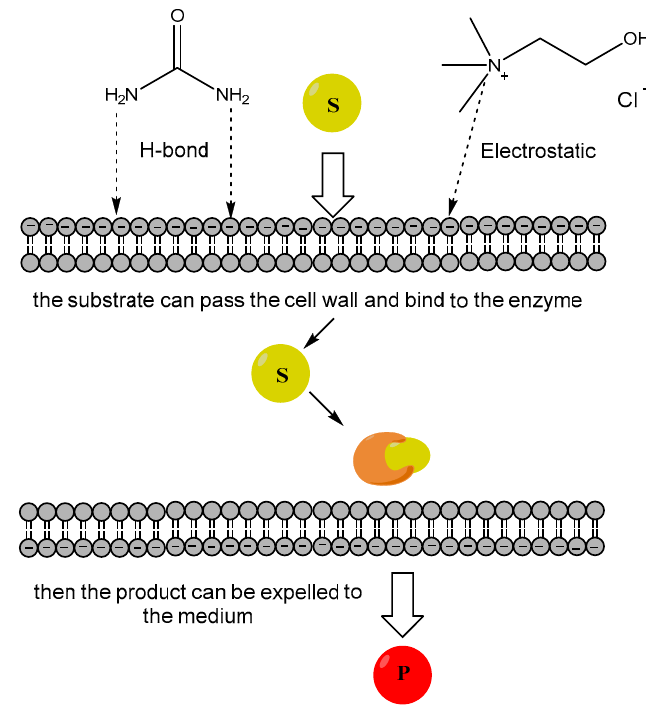
Figure 1. The effect of deep eutectic solvents (DES) on cell membrane permeability. The cations from the choline chloride and urea that form hydrogen bonds can disrupt the cell membrane, allowing the substrate to enter the cells, so then it can bind to the appropriate enzyme. Finally, the product can be released to the medium.